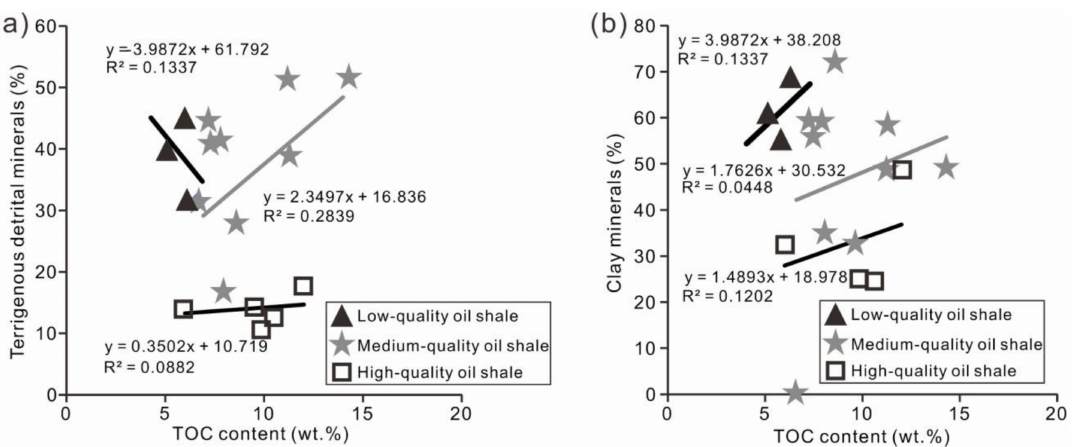
Figure 11. Relationships between total organic carbon (TOC) content and ( a ) terrigenous detri- tal minerals, and ( b ) clay minerals in the different-quality oil shales in the Shale Member of the Shimengou